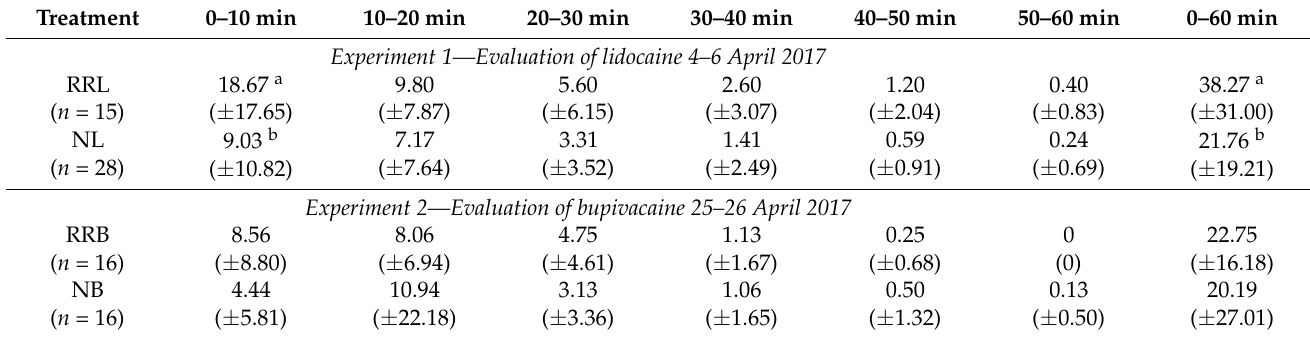
Table 6. Mean ( ± standard deviation) count of foot-stamping or kicking expressed by male lambs. Within each experiment, means within a column with differing uppercase superscripts (A, B) differ significantly ( p < 0.05), while differing lowercase superscripts (a, b) indicate a tendency to differ (0.1 > p > 0.05). RRL ring only, no local anesthetic; NL ring applied with lidocaine administered using the Numnuts ® tool; RRB ring only, no local anesthetic; NB ring applied with bupivacaine administered using the Numnuts ® tool; RRP ring only, no local anesthetic; NP ring applied with procaine administered using the Numnuts ®